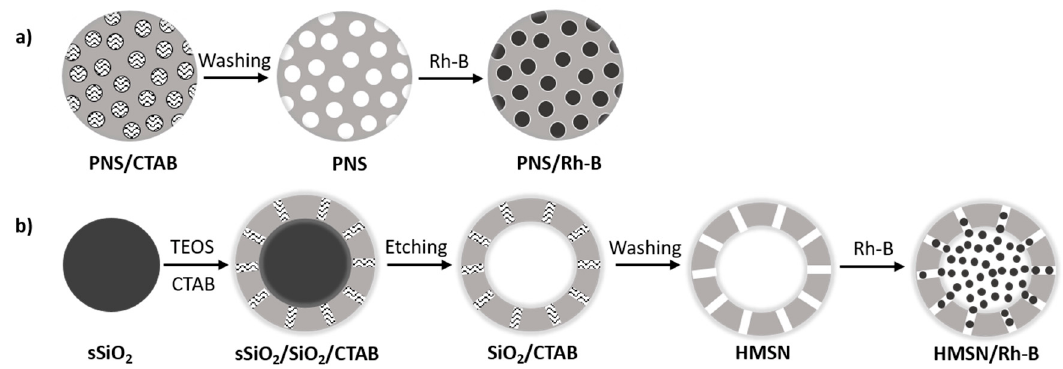
Figure 1. Schematic representation of the formation of porous nanosilica (PNS) ( a ) and hollow mesoporous silica nanoparticles (HMSNs) ( b ).